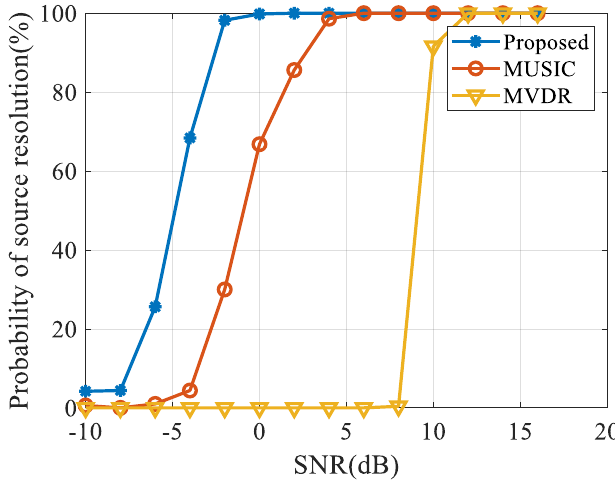
Figure 8. Results of the probability of source resolution versus SNR.